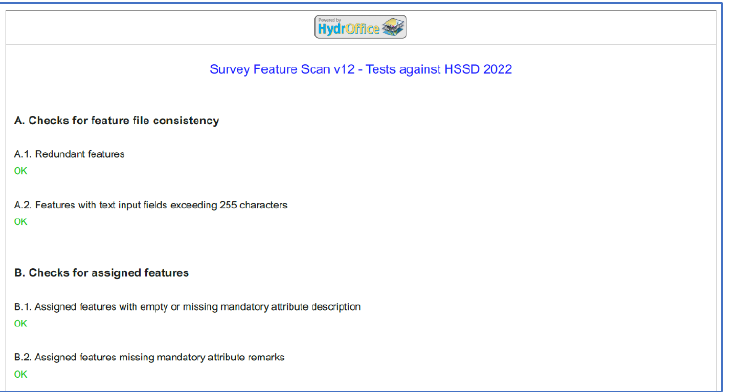
Figure 12. Feature Scan produces a PDF report that indicates which checks were performed and the results of the checks. At the end of the report, a summary indicates how many warnings and errors were identified, grouped by type.